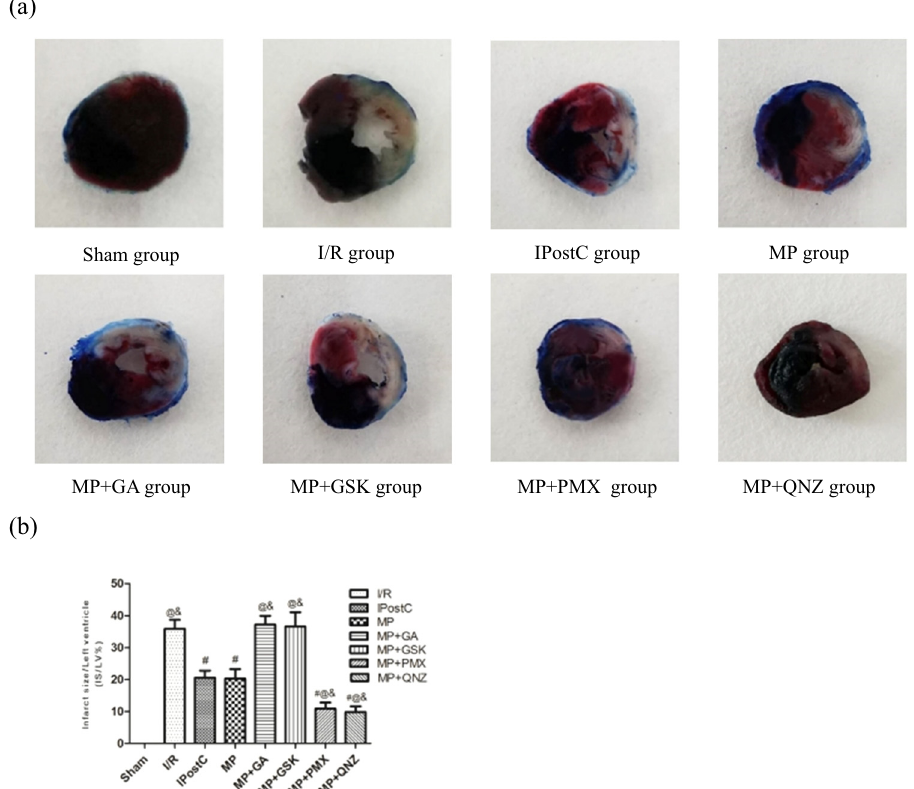
Figure 1: ( a ) E ff ects of IPostC, MP, and MP with treatment with the GA, GSK, PMX, and QNZ on myocardial infarct size after cardiac I/R injury ( IS/LV ) . ( b ) Quantitative analysis of myocardial infarct size. The results presented the mean ± standard deviation. # P < 0.05 vs I/R group; @ P < 0.05 vs IPostC group; & P < 0.05 vs MP group, n = 5 for each group. I/R: ischemia/reperfusion; MP: morphine postconditioning; GA: geldanamycin; GSK: GSK - 690693; PMX: PMX 205; QNZ: